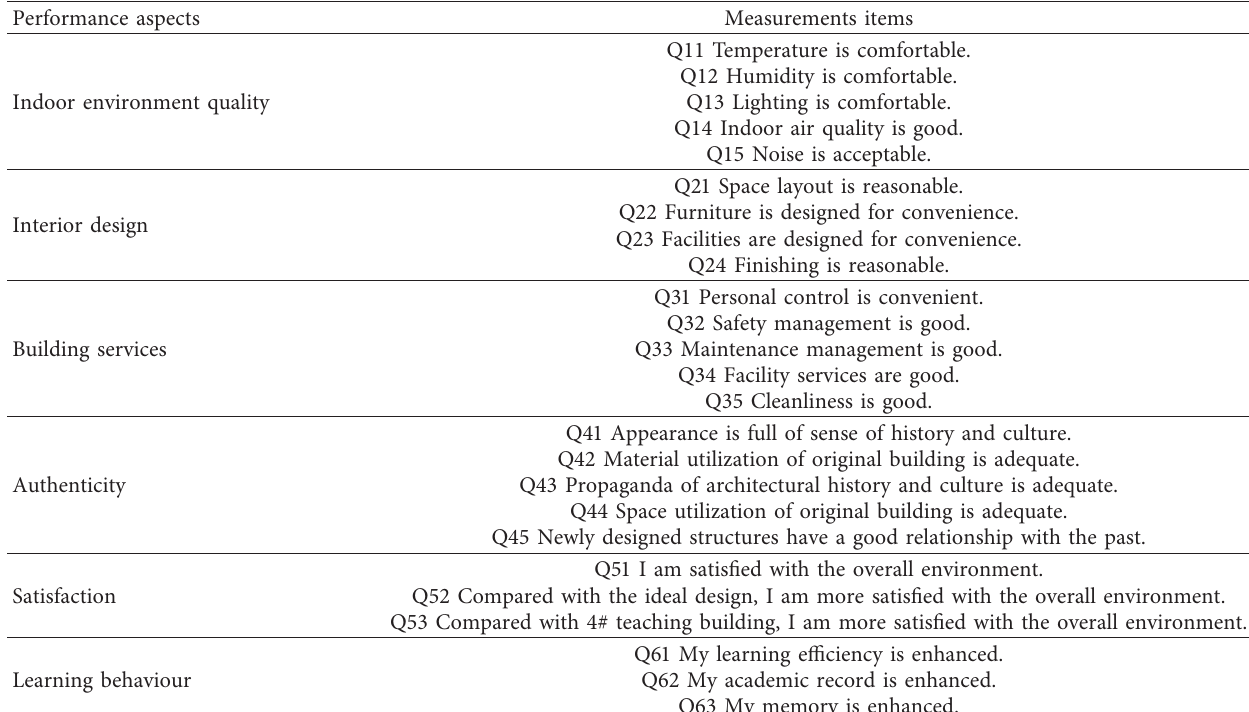
Table 4: The measurement items of performance of adaptively reused